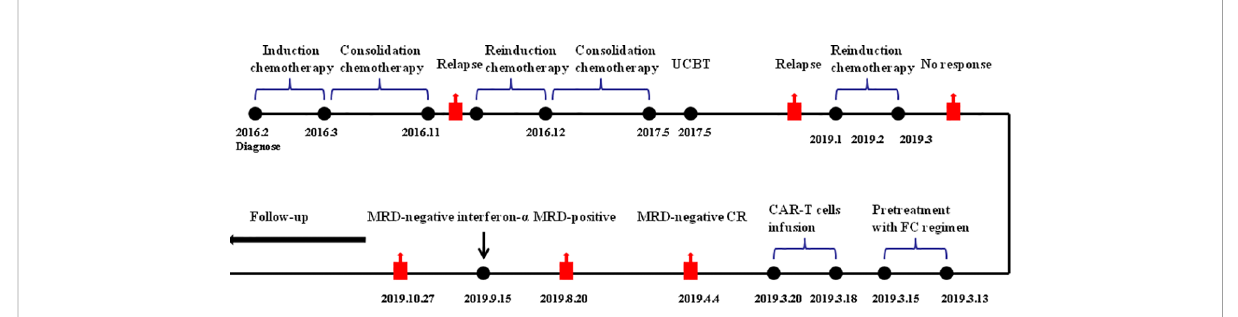
FIGURE 3 Summary of clinical course. FC, fl udarabine and cyclophosphamide regimen; CAR-T cell, chimeric antigen receptor T cell; MRD, minimal residual disease; IFN- a , interferon- a